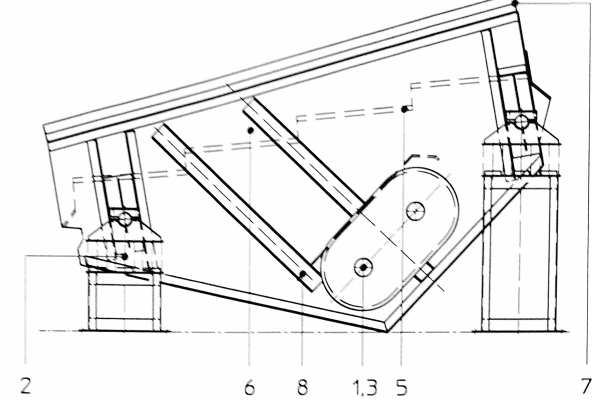
Figure 2. The overall side view of the vibrating sieving screen.